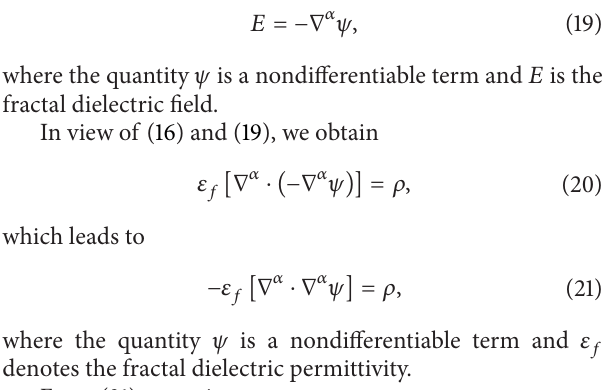
where both 𝜓(𝑥, 𝑦) and 𝜌(𝑥, 𝑦) are nondifferentiable